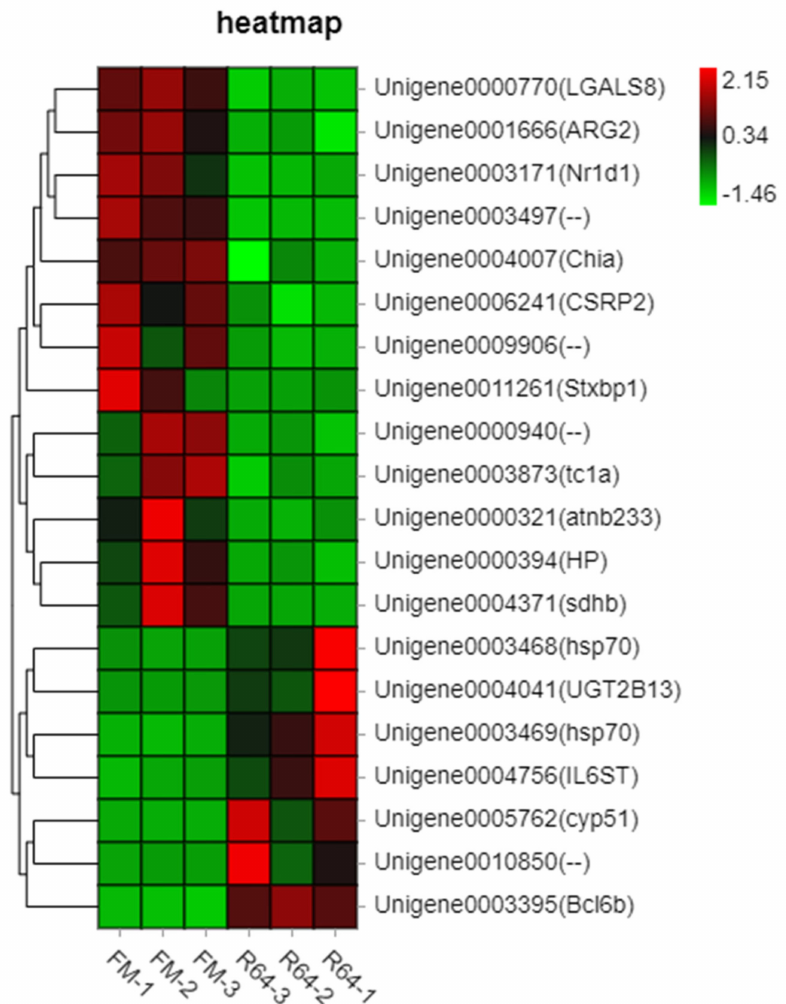
Figure 6. Heatmap of the top twenty genes differently expressed in liver of the FM group and R64 group. The graph was constructed in an R environment using the heatmap package, and using the normalized log2CPM (counts per million) as